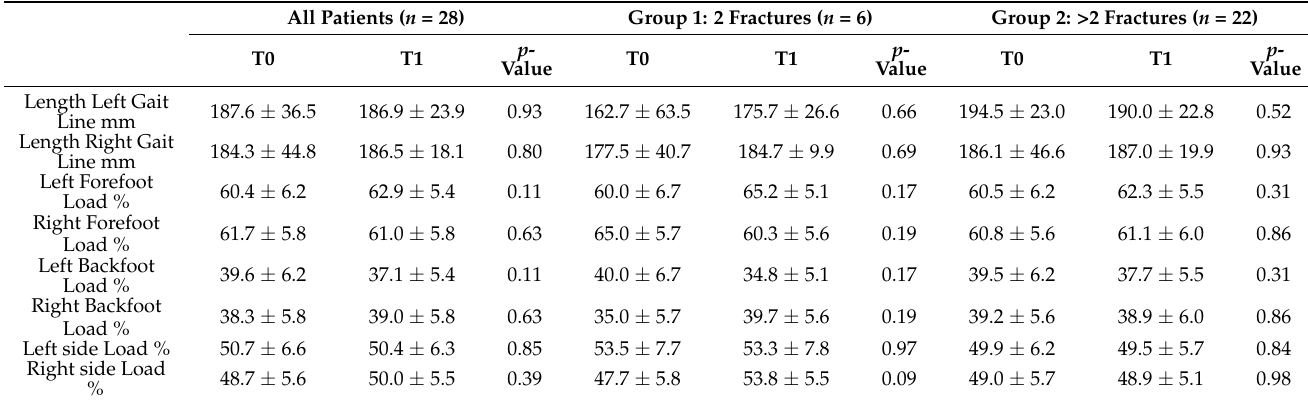
Table 4. Dynamic